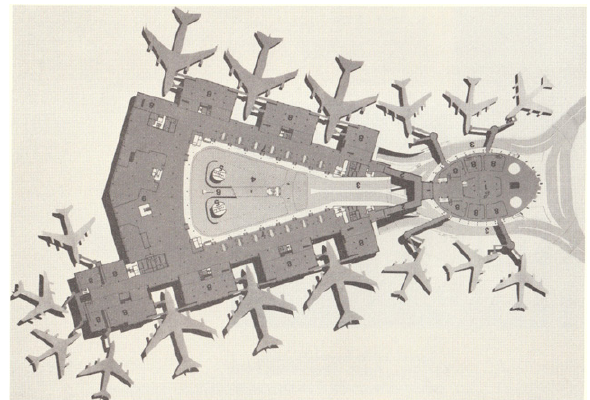
Figure 2. TAMS. Expansion of the Pan American Passenger Terminal at John F. Kennedy International Airport, Worldport , (1969-73), included in Detailed Design (1983), by Walther